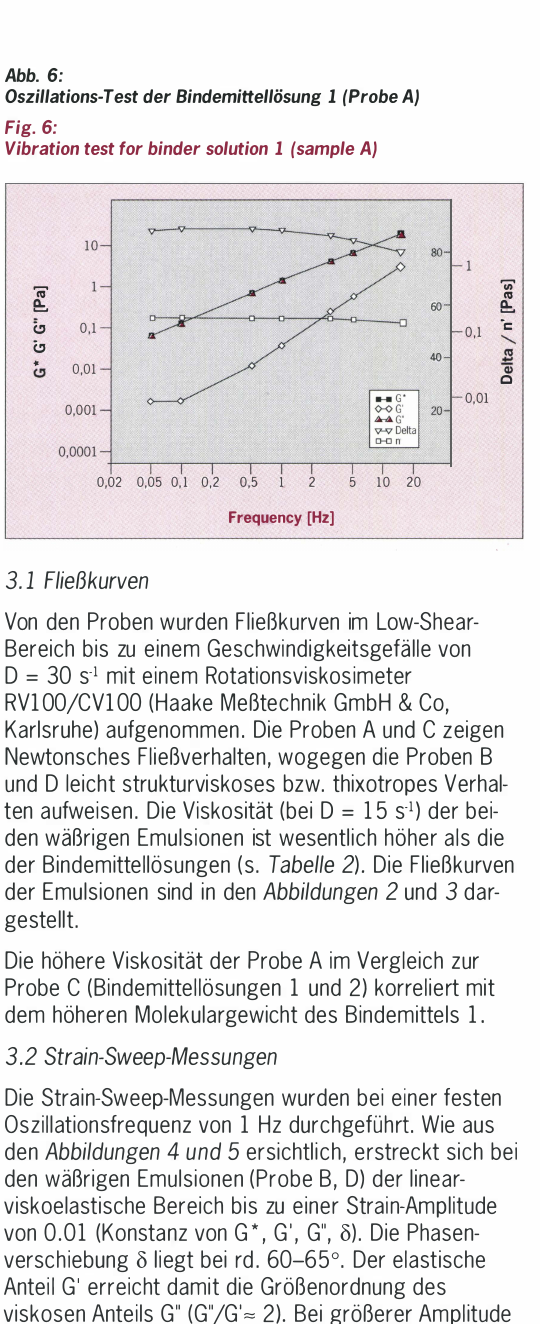
Abb. 8: Oszillations-Test der Emulsion 1 (Probe B) Fig. 8: Vibration test for emulsion